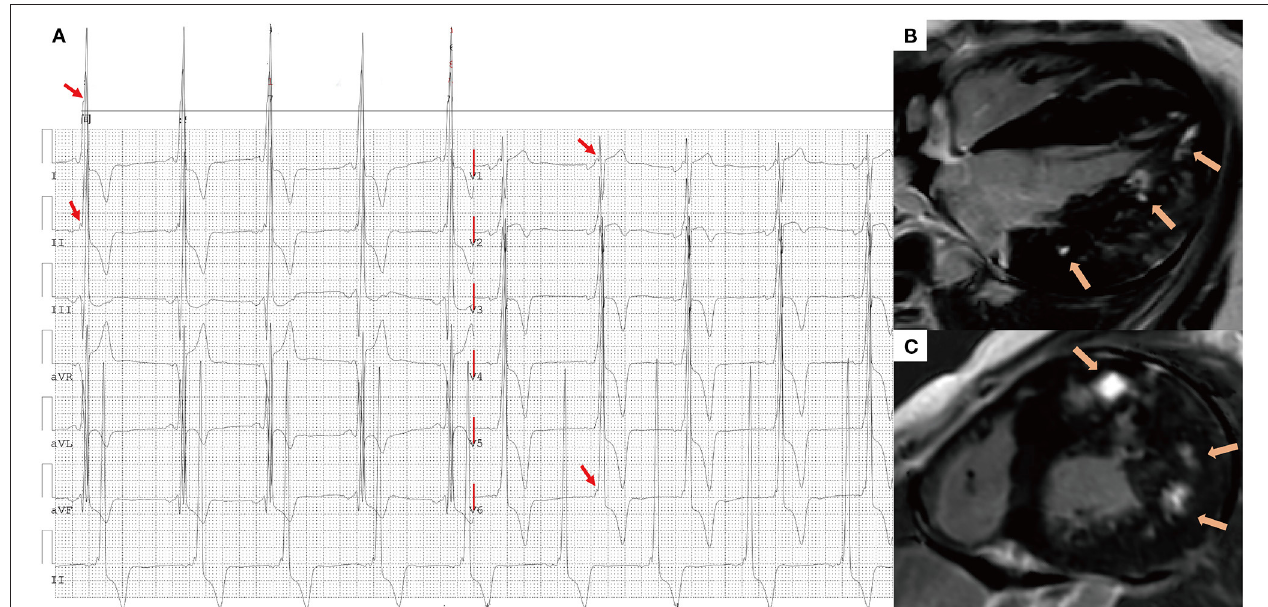
FIGURE 4 | A 16-year-old male presented with chest tightness and shortness of breath and was genetically diagnosed with Danon disease (mutation site: c.936G > A). (A) f-QRS with a notched R pattern (red arrows) were found in the lateral leads (I, aVL, V6); the total f-QRS score was 3. (B) Four-chamber view and (C) short-axis view of LGE images on CMR showed patchy fibrosis/scarring in the lateral wall of LV (orange arrows). Global LV LGE% was 20%. f-QRS, fragmented QRS; LGE, late gadolinium enhancement.